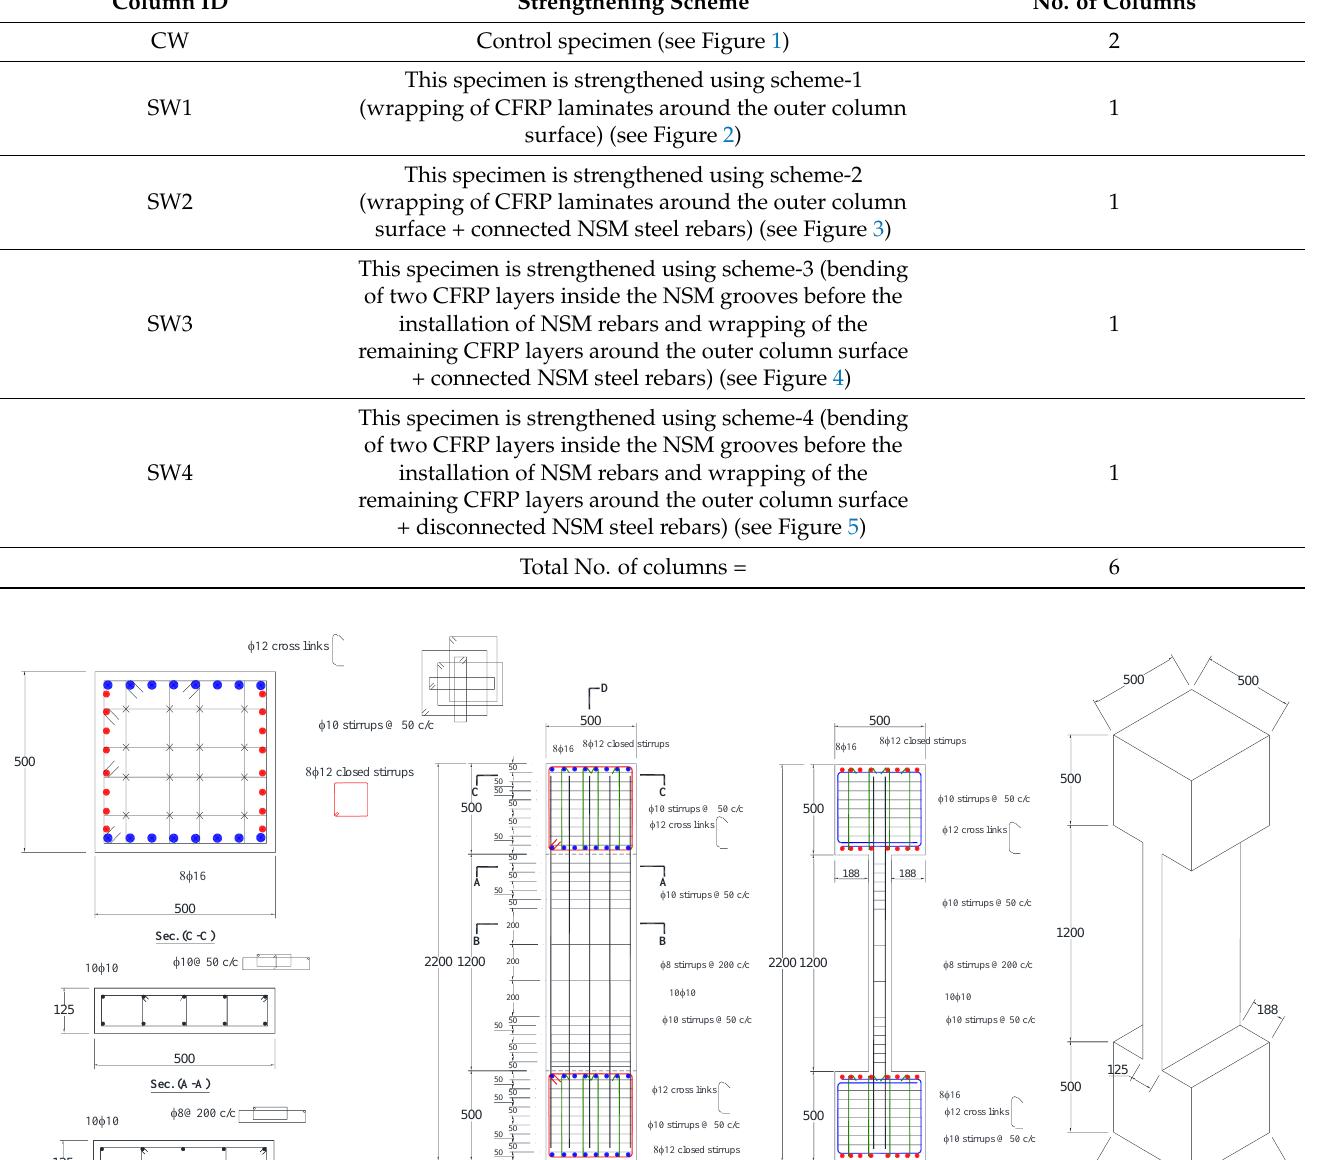
Figure 2. Dimensions and reinforcement detailing of strengthened specimen SW1 (note: all dimen- sions are in mm). The second strengthening scheme (scheme-2) employed a combination of vertical NSM steel rebars and externally bonded CFRP wrapping. The provided NSM rebars were 14 ф10, which enhanced the column reinforcement from 1.26% to 3.01%. The provided vertical NSM rebars require transverse ties for preventing their buckling. However, in this scheme of strengthening, CFRP wrapping was utilized to support the NSM rebars later- ally. The CFRP wrapping scheme was the same as that adopted for column SW1, i.e., three layers in the central portion and four layers at the two ends. The strengthening details of